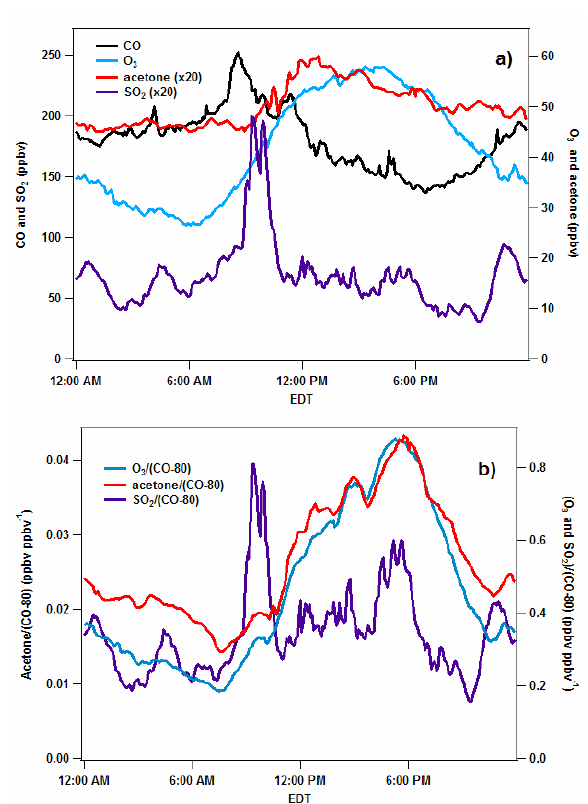
Figure 6. Diurnal profiles of selected trace gases, with (b) and without (a) normalization to CO less its regional background value.